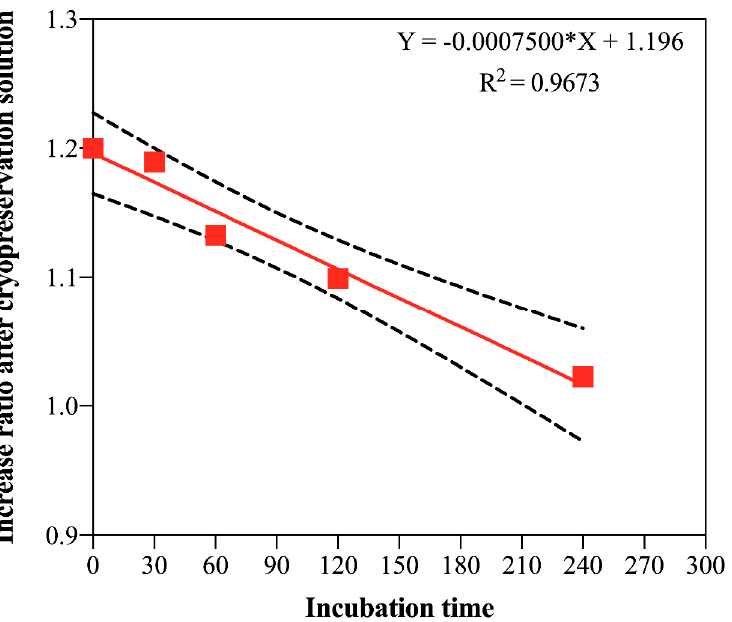
Figure 3. Linear regression showing the increased ratio in fresh material of G. chacoensis embryogenic cultures 30 days after incubation (0, 30, 60, 120, and 240 min) in cryoprotective solution. * Indicates that linear regression was significant (F-test, p ≤ 0.05).